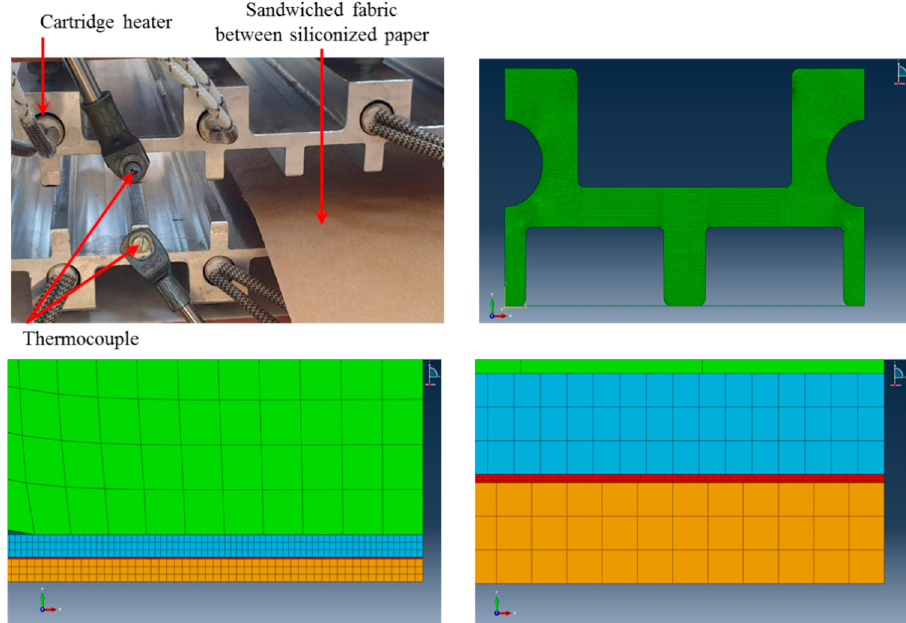
Figure 4. Thermal consolidation apparatus and its finite element model, and that of consolidated materials (green: aluminum platen, light blue: silicon paper, red: nanofabric, orange: carbon fiber fabric).